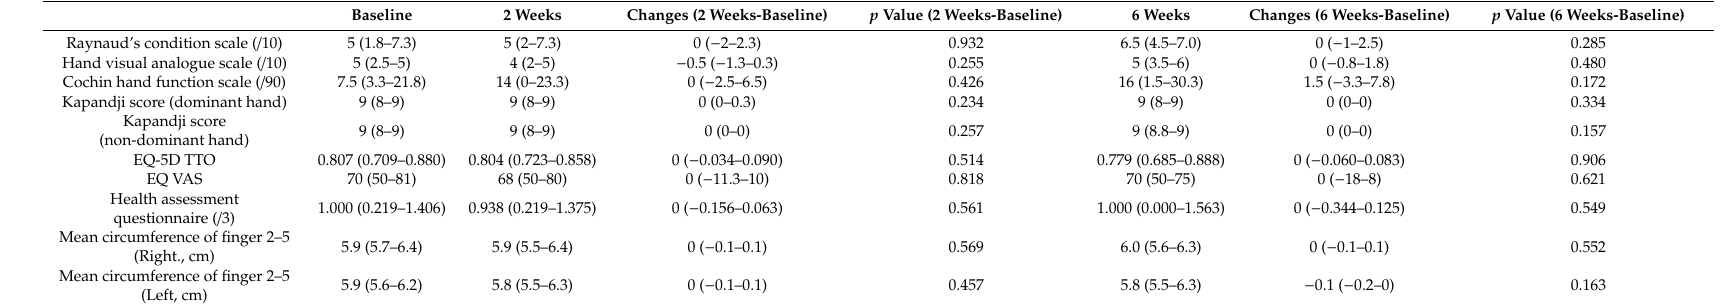
Table 3. Changes of patient-reported indices, hand function, and quality of life (2 weeks, 6 weeks).